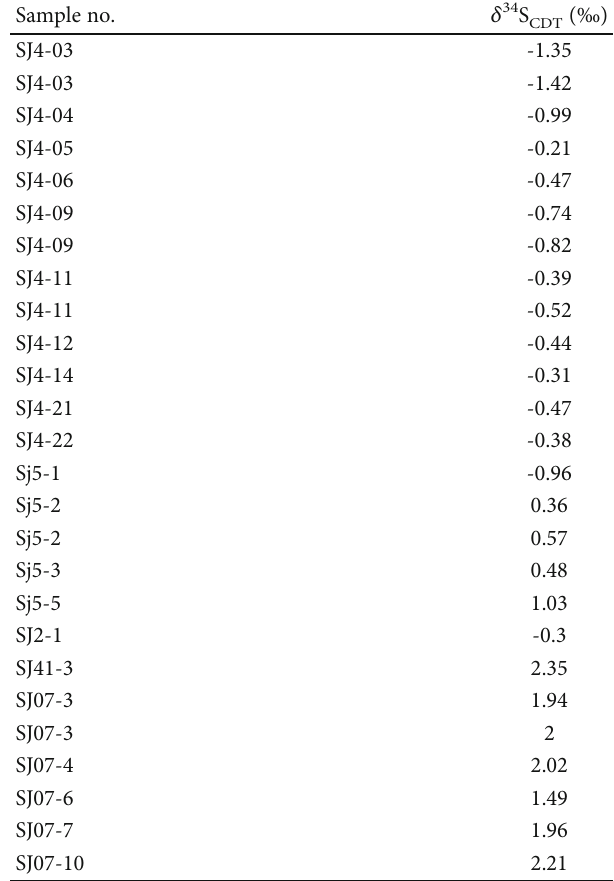
Table 3: H-O isotope data of quartz and calcite from the Longmendian Ag-Pb-Zn deposit (data from this study). Sample no.